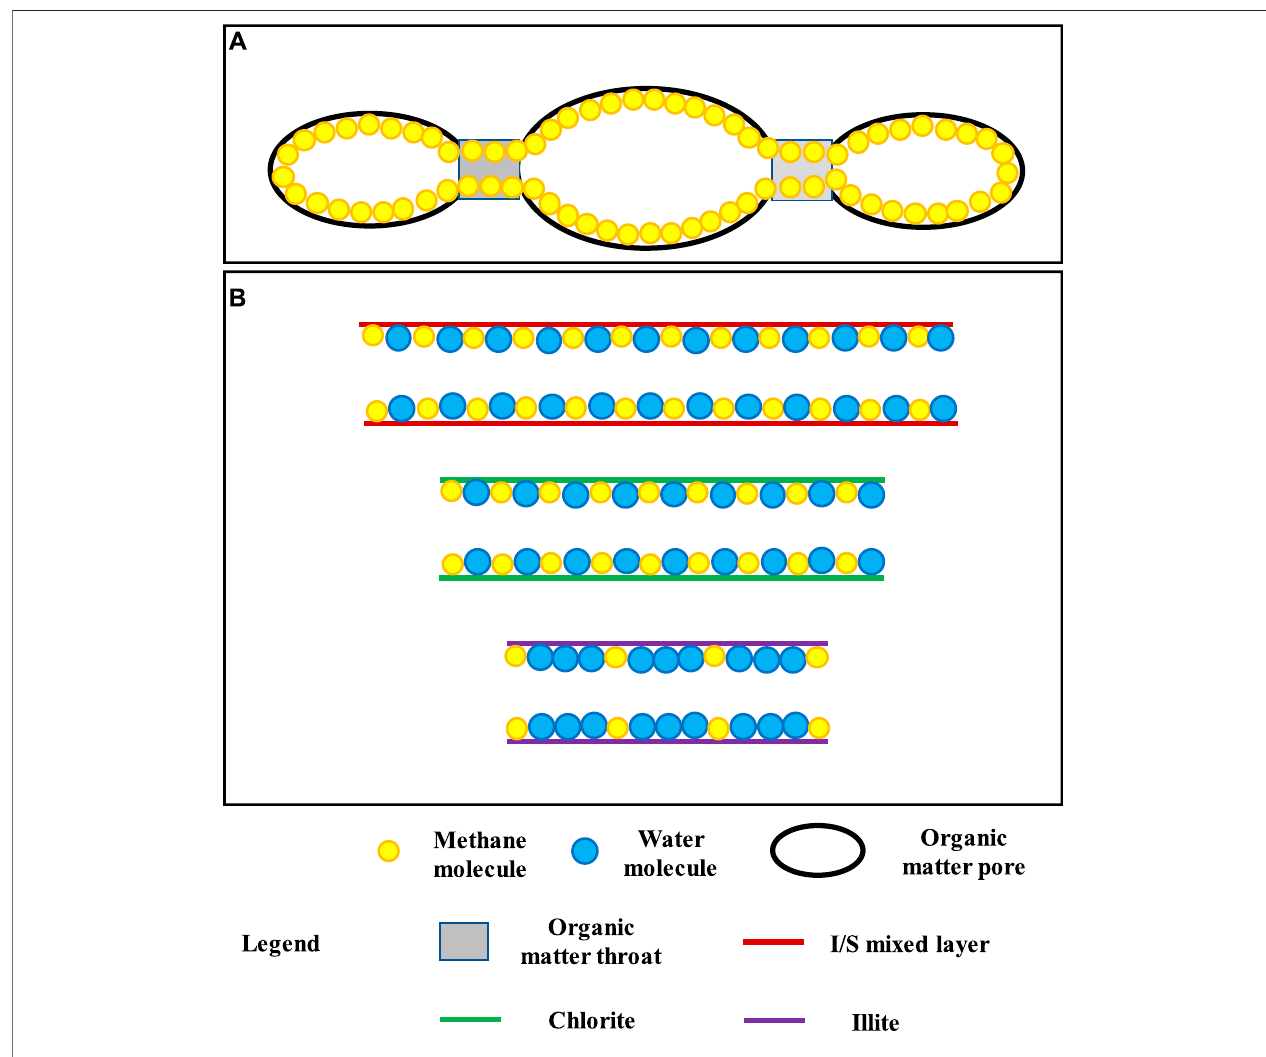
FIGURE5| Patternofmethanemolecule adsorption ondifferentmediainhighlyevolvedmarine shales. (A) Methanemoleculesadsorbedontheinternalsurfaceof organic matter pores; (B) methane molecules adsorbed on the internal surface of clay minerals, which are mainly montmorillonite, I/S mixed layer, and chlorite.